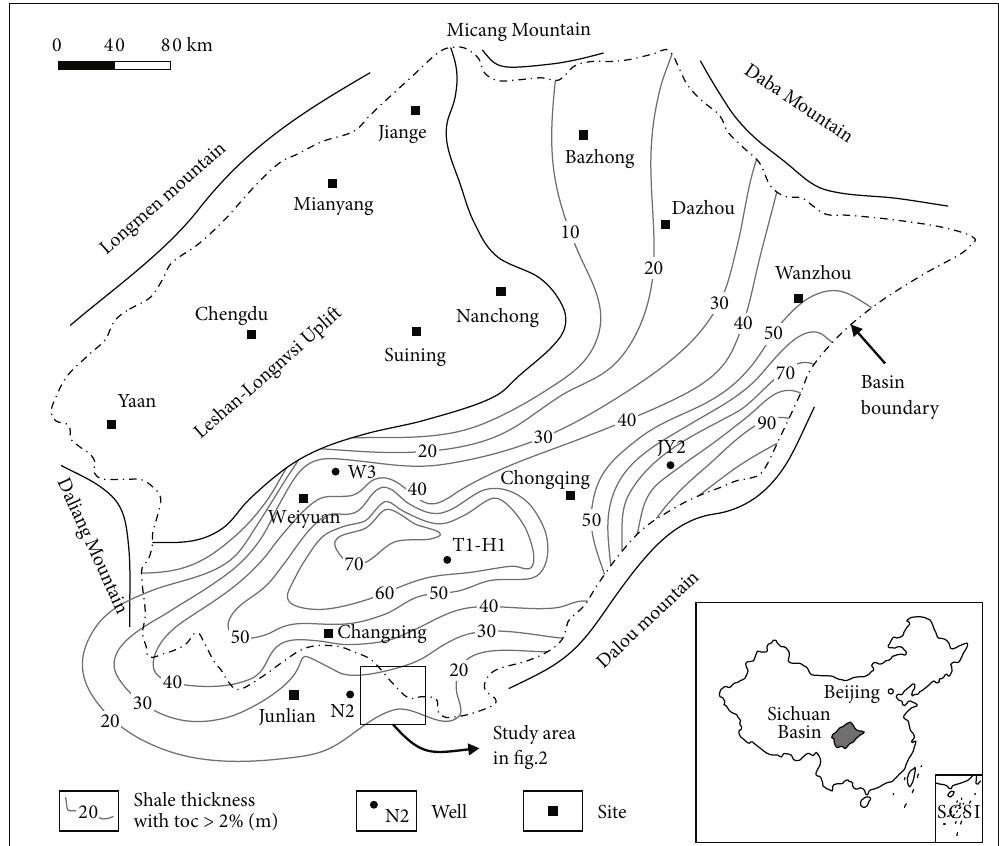
fig.2Weiyuan Changning Junlian Figure 1: Geographic location and characteristics in the southern Sichuan Basin, China